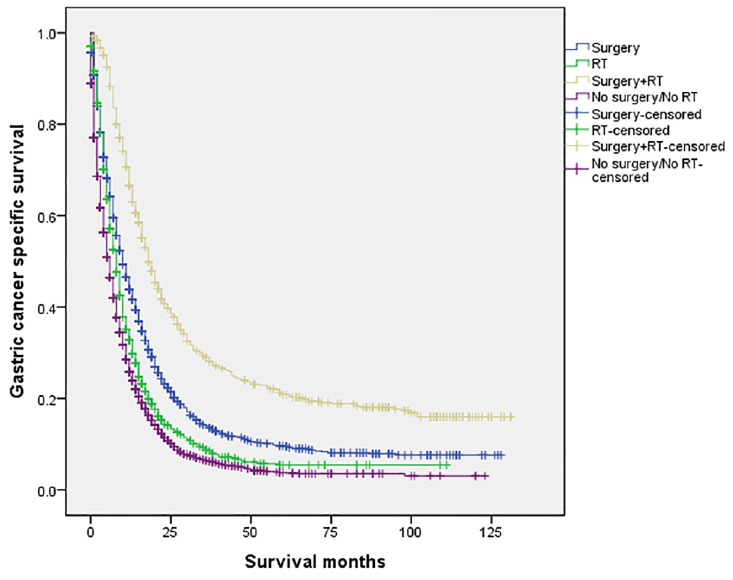
Fig 5. Survival curves in patients with advanced gastric cancer according to four subgroups in age < 75 years (P < 0.001). RT: radiation.